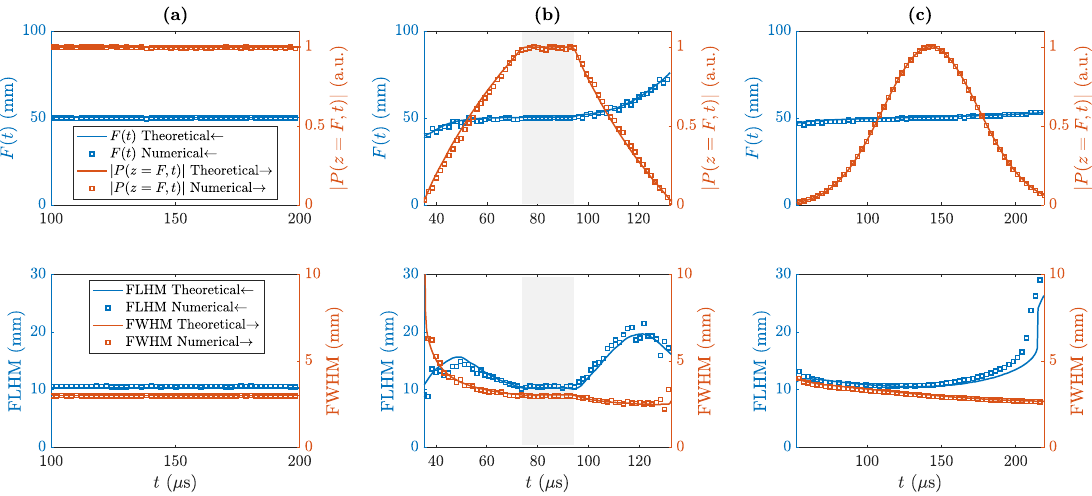
Figure 5. Main focusing parameters for the three different waveforms: ( a ) Continuous Wave, ( b ) Modulated Rectangular Pulse, and ( c ) Modulated Gaussian Pulse. Top plots depict the focal distance and focal intensity as a function of time, while bottom plots show FLHM and FWHM resolutions. Gray areas in ( b ) represent the transient